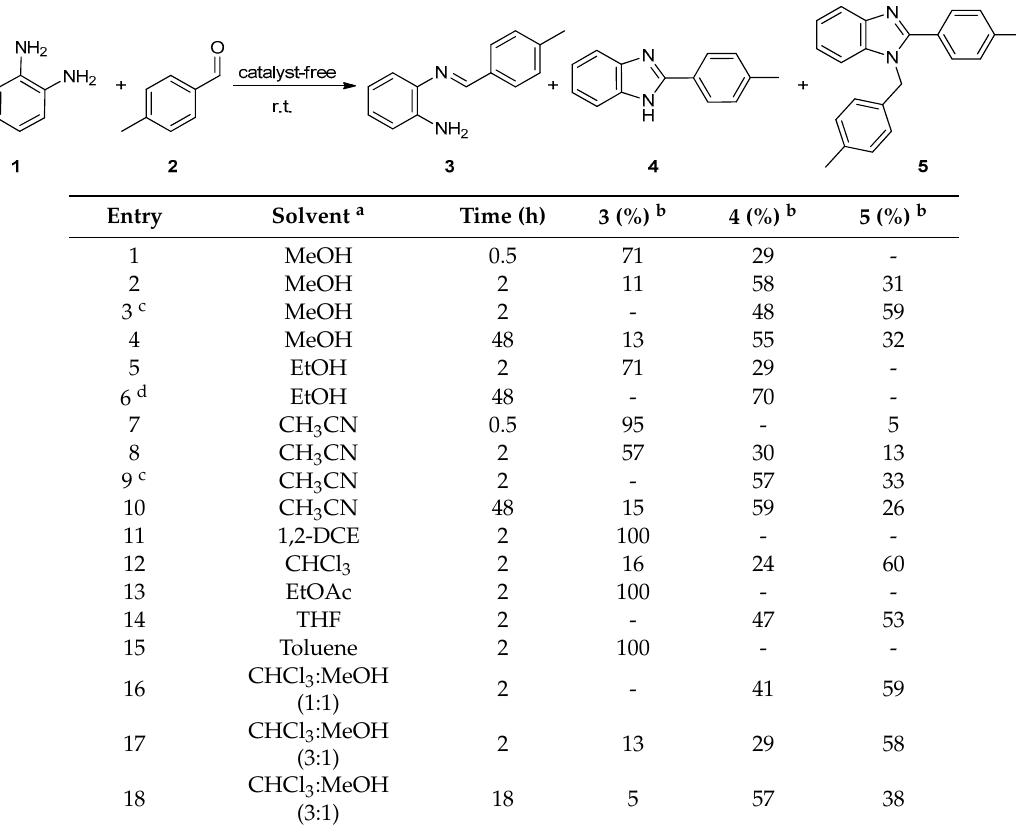
Table 1. Solvent screening for the reaction between 1 and 2 in the absence of catalyst.